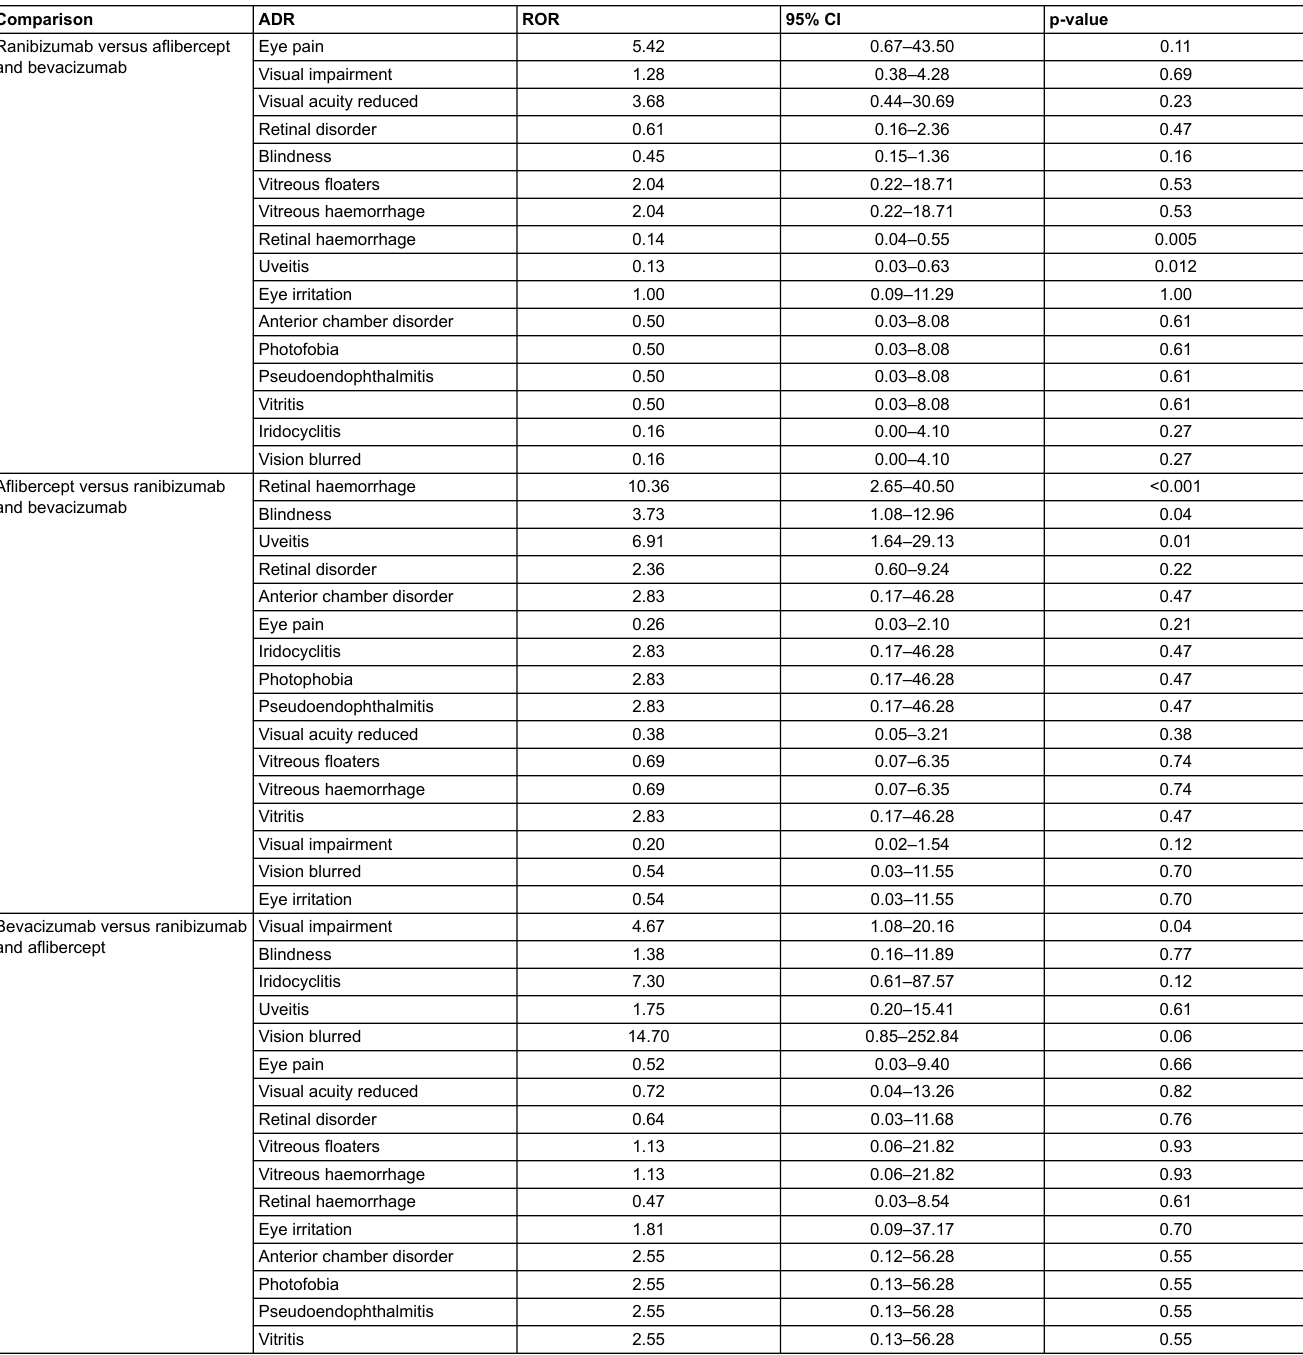
Table 4: Main ADRs for ranibizumab, bevacizumab, and aflibercept, with reporting odds ratio, 95% confidence intervals, and p-value against the other two drugs.